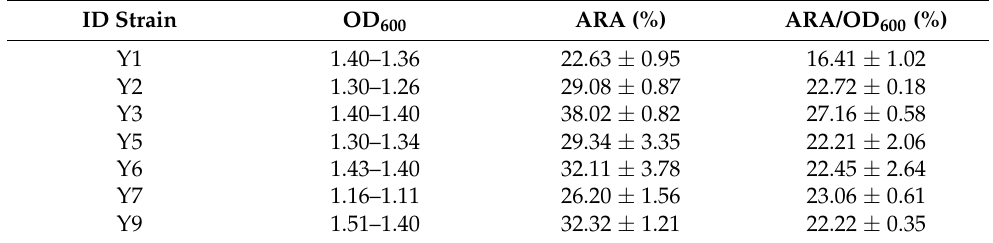
Table 3. DPPH • antiradical activity (ARA % standard and corrected for OD 600 ) by yeast strains. ID Strain OD 600